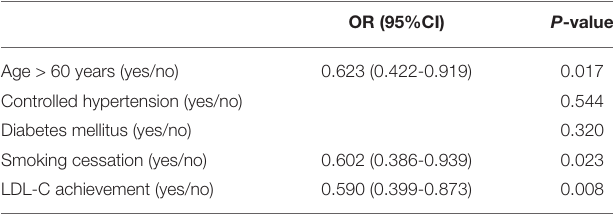
TABLE 6 | Multivariable logistic regression analysis of factors for the changes in